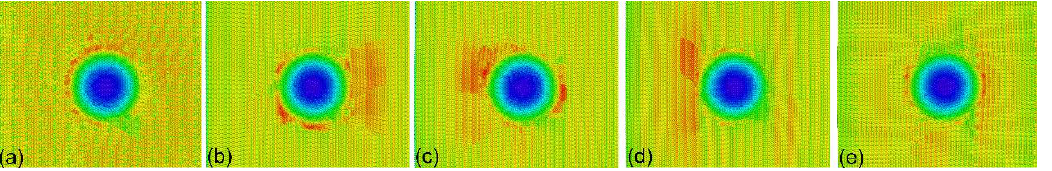
Figure 8. Surface morphology of twinned Al with different inclination angles. Inclination angle: ( a )0°; ( b ) 26°; ( c ) 45 o ; ( d )64°; and ( e ) 90°. Atoms are colored according to their atomic heights.